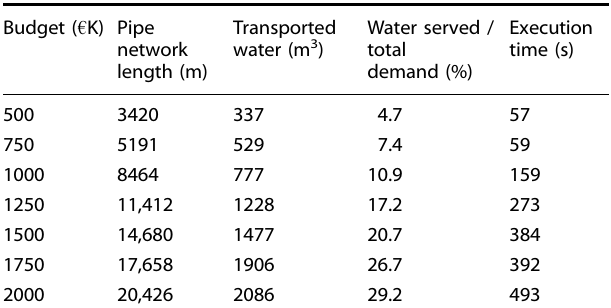
Table 4. LB algorithm results over a randomly selected branched network area (Girona fi ve clusters, blue cluster water tank in Fig. 3, public and private uses).